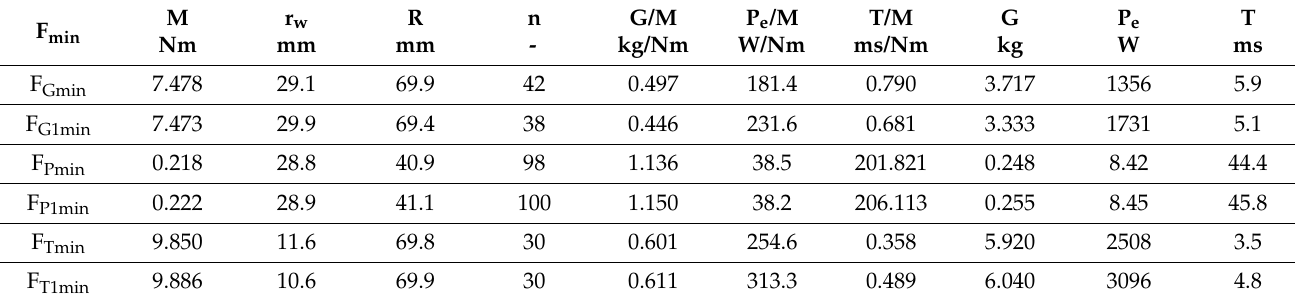
Table 5. Optimization results for the whole intervals of decision